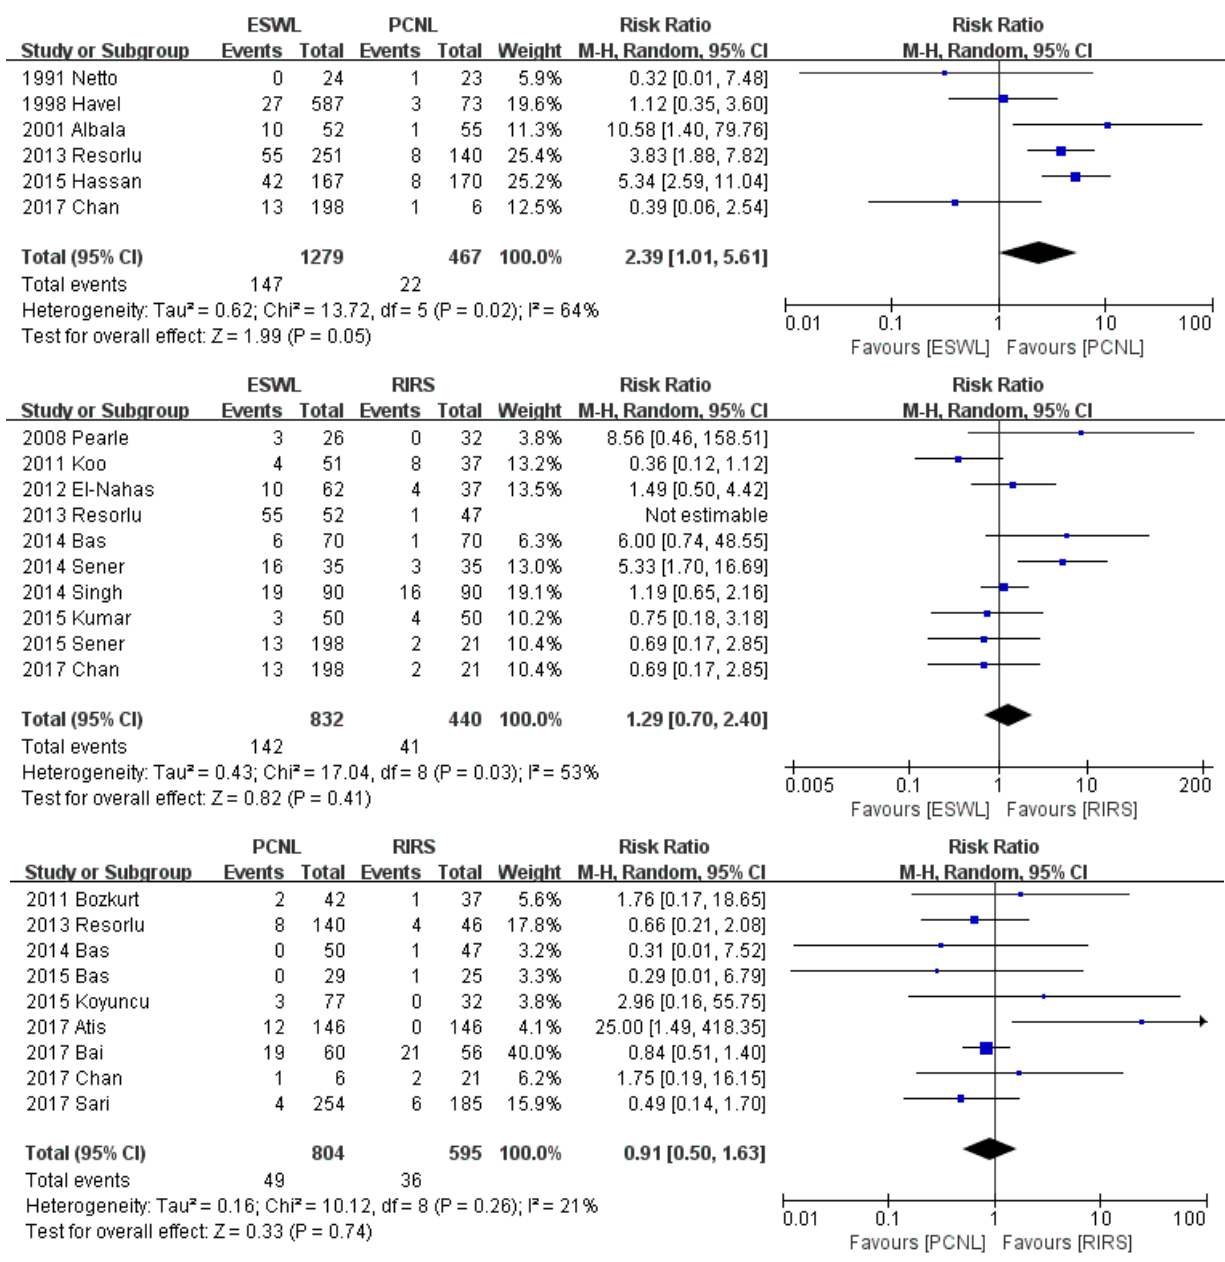
Figure 9. Meta-analysis of auxiliary procedure: ( a ) ESWL vs. PCNL; ( b ) ESWL vs. RIRS; and ( c ) PCNL vs. RIRS. A sub-group analysis was conducted of the criterion of a 2-cm stone diameter. A comparison of SFRs is shown in Figure 10. In the group of stones smaller than 2 cm, like